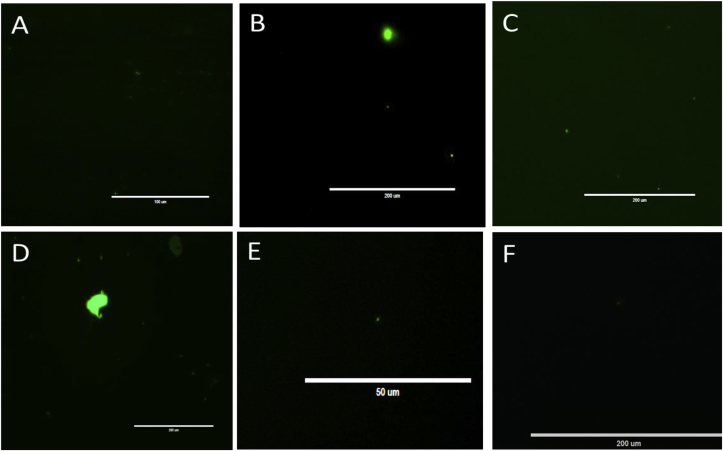
SYBR® Green I emulsions by fluorescent microscopy, prepared with: A) BRIJ 35; B) Tween 20; C) NP 40; D) Triton-X100; E) EGEPAL CA-630; F) SDS. (For interpretation of the references to colour in this figure legend, the reader is referred to the Web version of this article.)